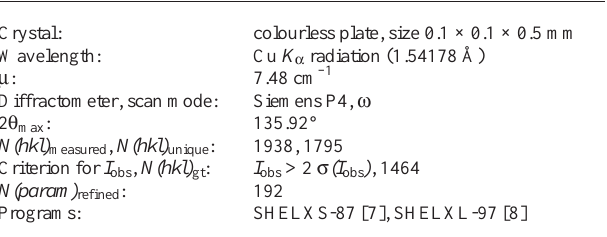
Table 1. Data collection and handling.